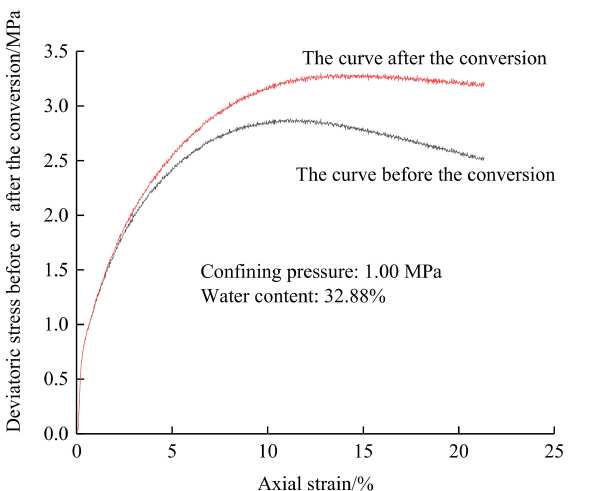
Figure 5. Contrast of the curves before and after the conversion (the black curve and the red curve correspond to the curve before and after the conversion is performed, respectively).